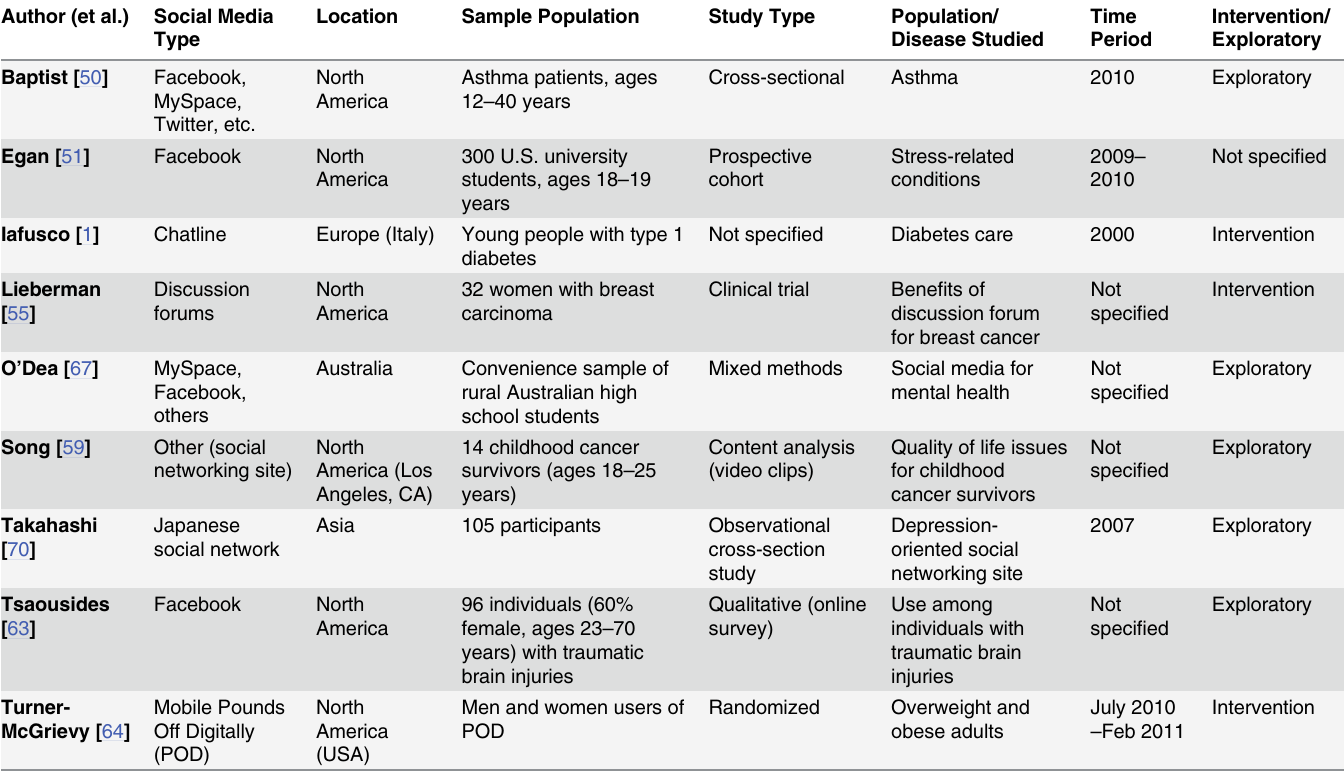
Table 10. Characteristics of 9 non-infectious diseases studies addressing research question 2 a